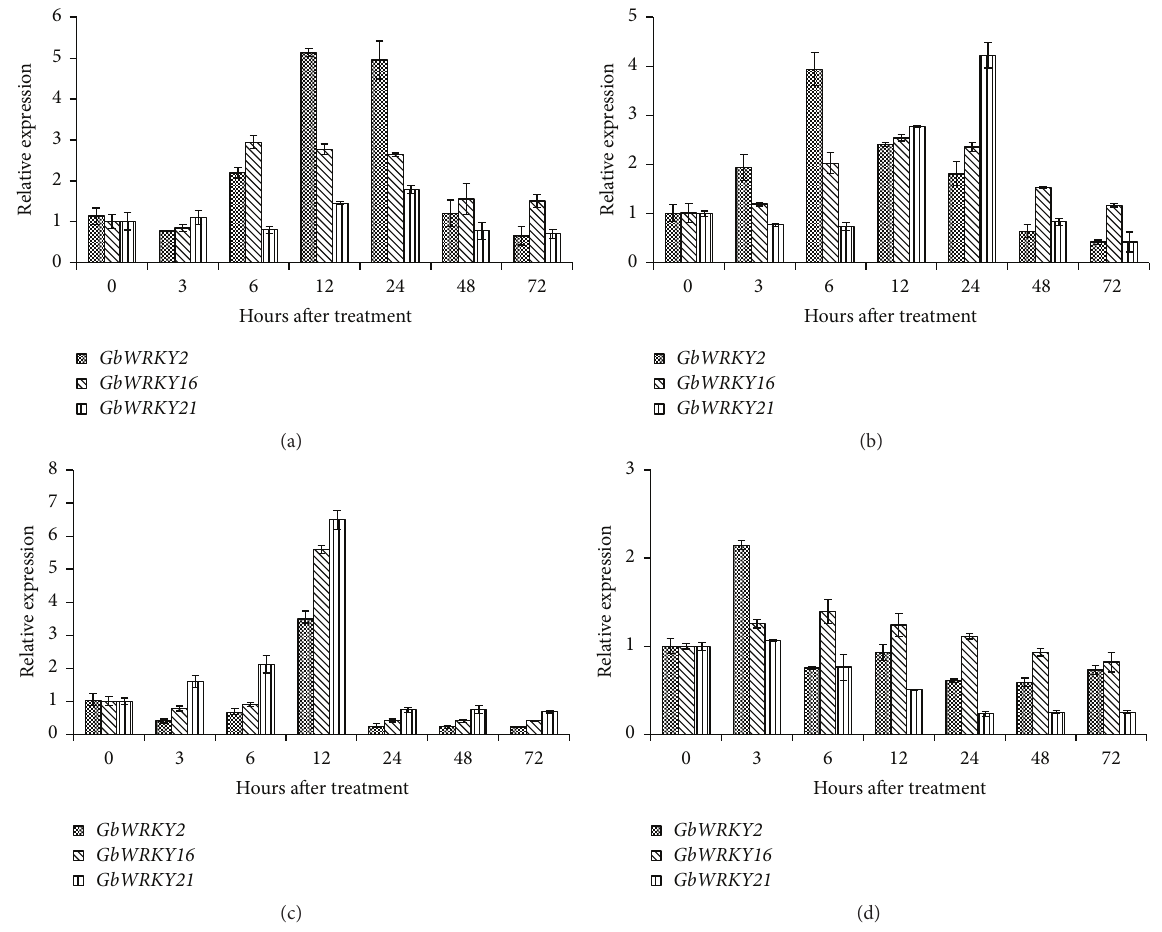
Figure 3: Relative expression levels of GbWRKY2 , GbWRKY16 , and GbWRKY21 with ABA (a), SA (b), ETH (c), and MeJA (d) treatments. Relative expressions of GbWRKY2 , GbWRKY16 , and GbWRKY21 at various hours after treatment under ABA, SA, ETH, and MeJA treatments with GbGAPDH gene as internal reference gene. Each sample was individually assayed in triplicate. Values shown represent the mean reading from three treated samples and the error bars indicated the standard errors of the